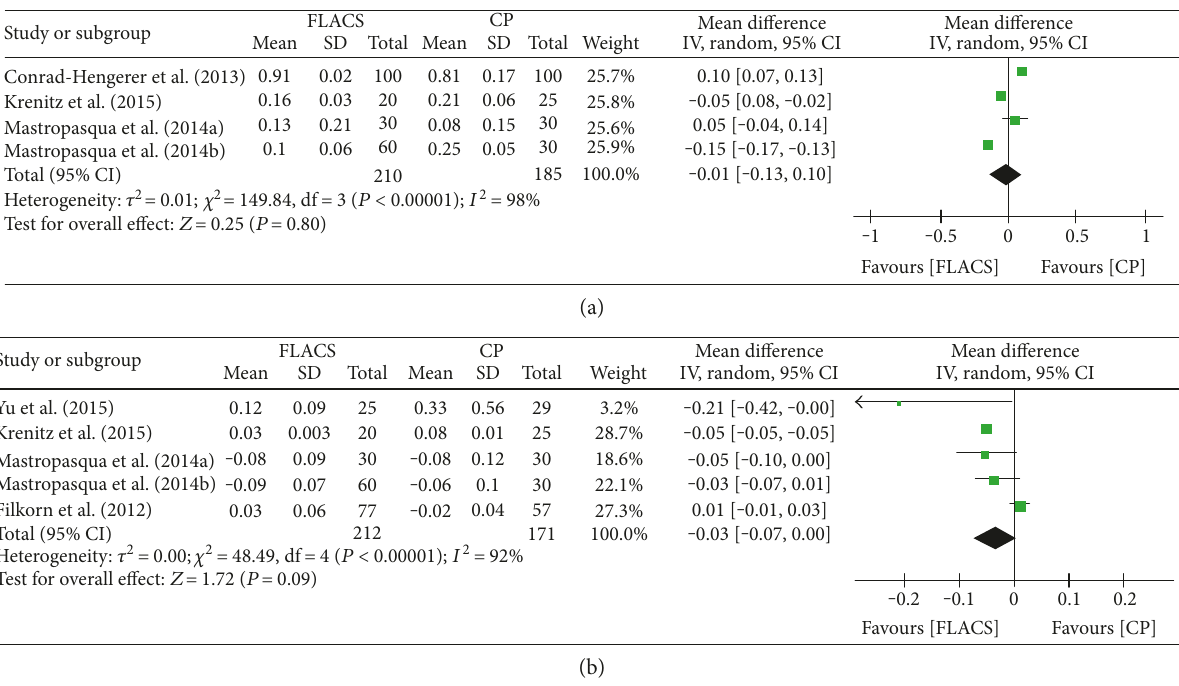
Figure 4: Forest plots displaying the e ff ect of femtosecond laser-assisted cataract surgery (FLACS) versus conventional phacoemulsi fi cation cataract surgery (CPCS) on visual acuity. (a) Uncorrected distance visual acuity. (b) Corrected distance visual acuity.